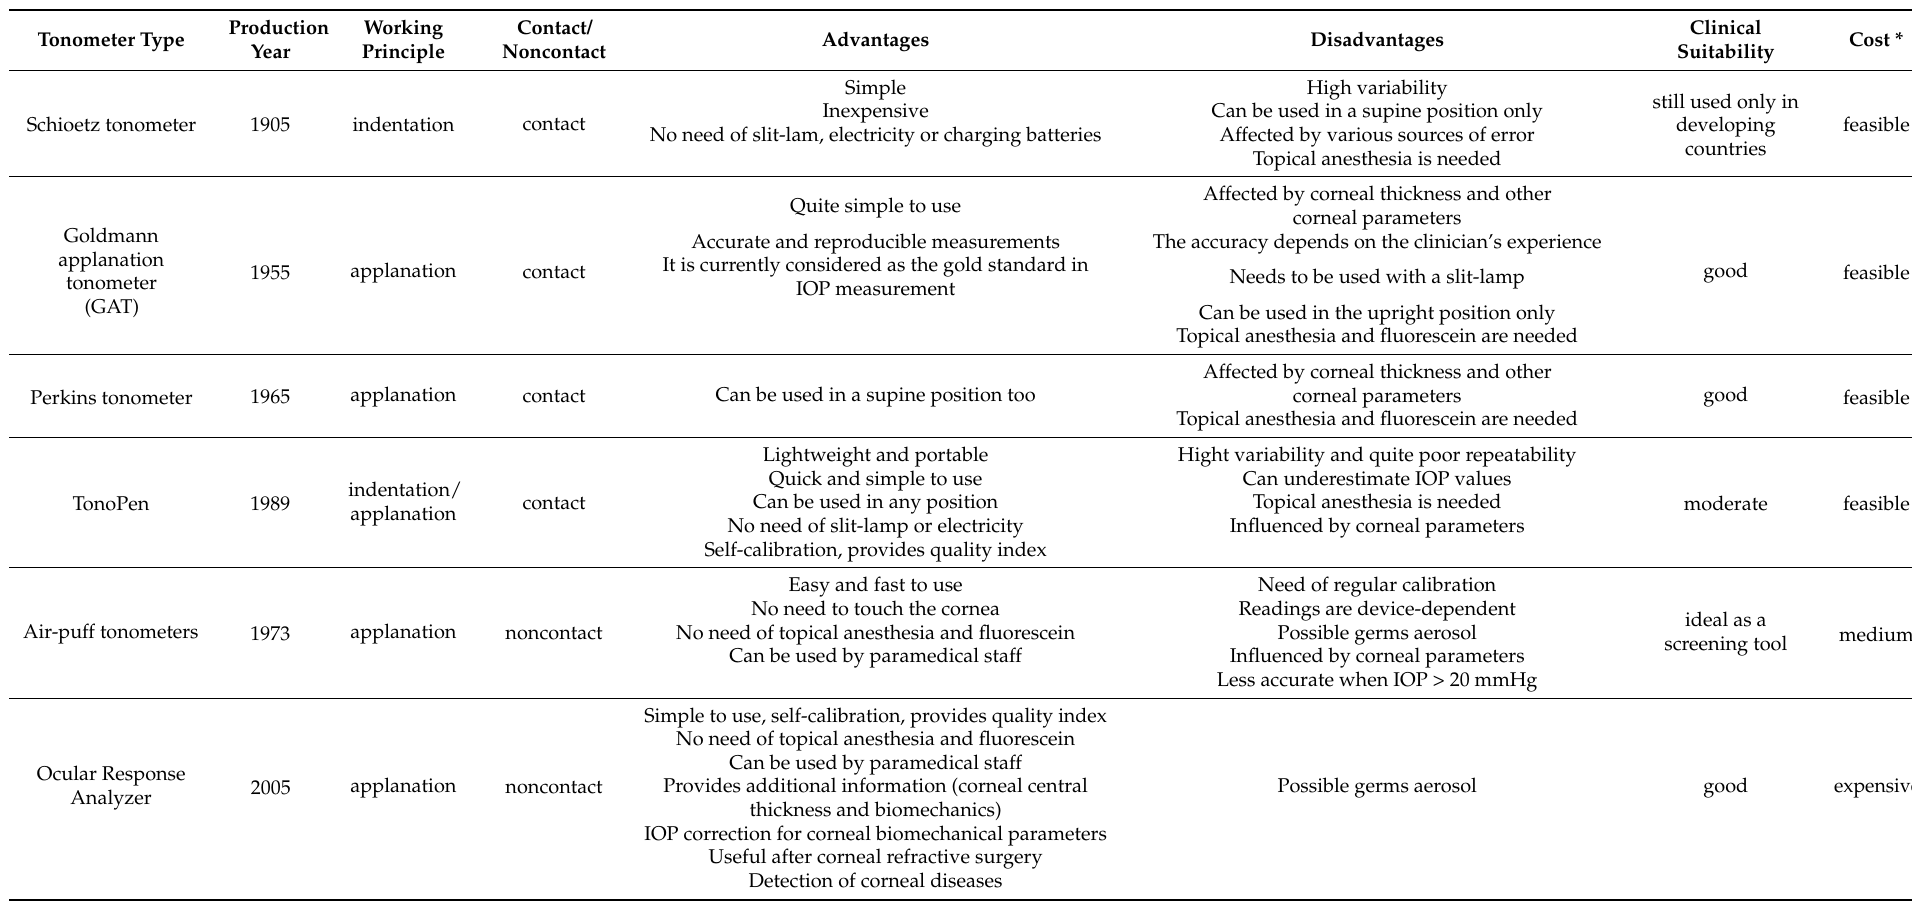
Table 1. Summary of the characteristics of the various available